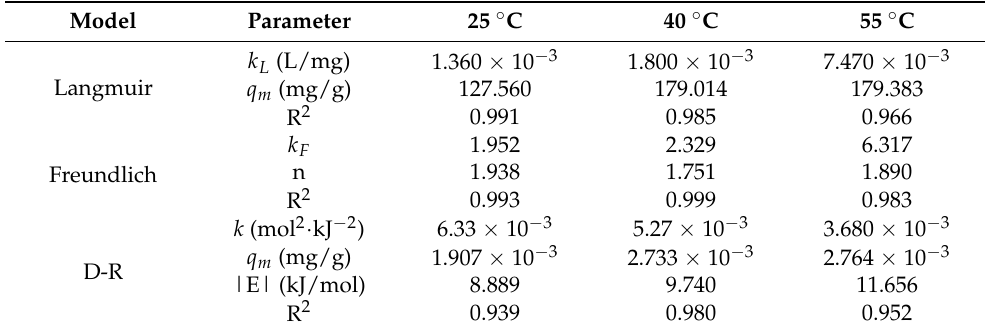
Table 3. Adsorption model parameters.